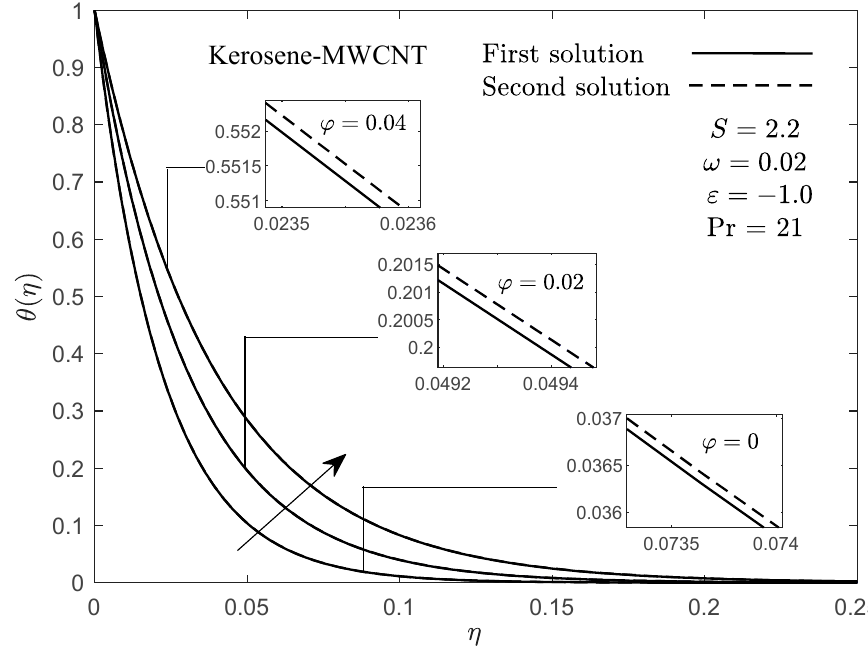
Figure 11. Temperature profiles θ ( η ) for some values of ϕ .